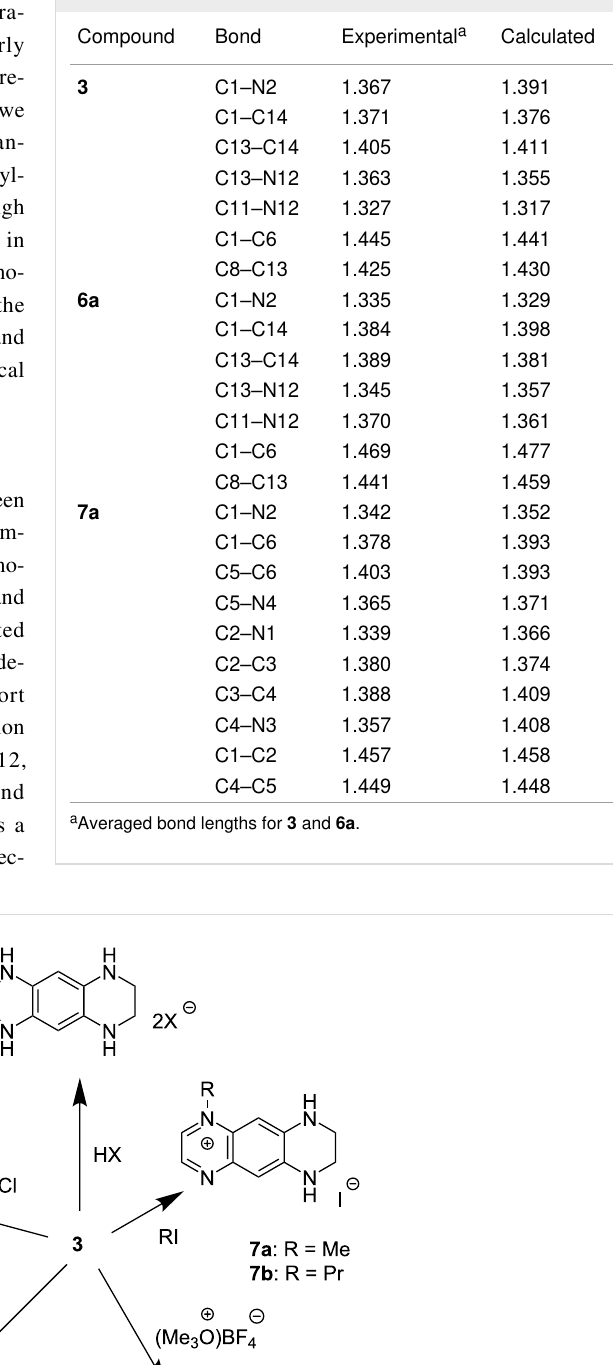
Table 1: Experimental and calculated selected bond lengths